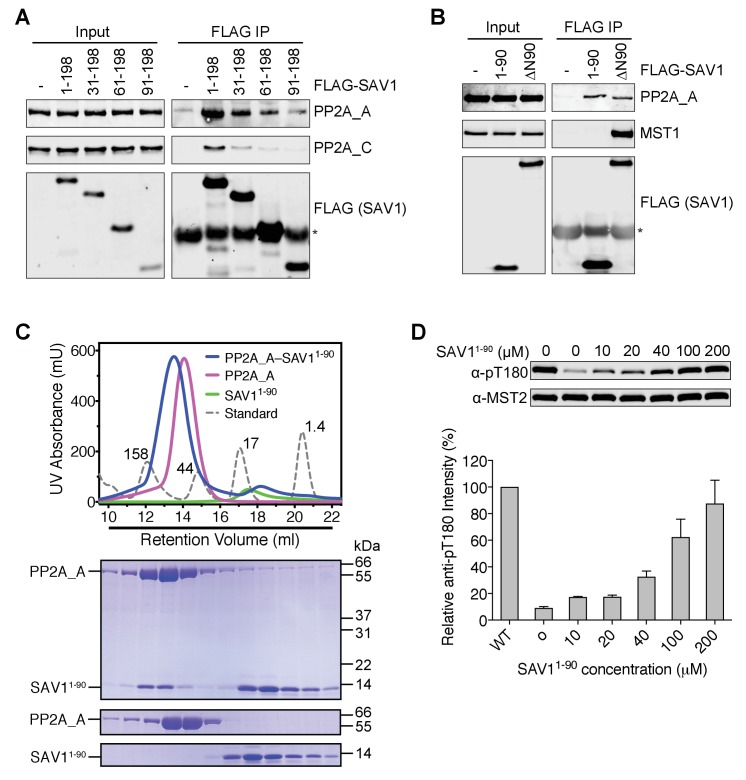
The N-terminal region of SAV1 directly inhibits PP2A.(A and B) Association of PP2A A-C with the N terminal region of SAV1. 293FT cells were mock transfected or transfected with the indicated FLAG-SAV1 plasmids. The total cell lysates (input) and anti-FLAG IP were blotted with the indicated antibodies. Asterisk designates IgG. (C) UV traces of the PP2A A and SAV11-90 complex (blue line), PP2A A alone (magenta line), SAV11-90 alone (green line), and molecular weight standard (dashed line, corresponding molecular weight indicated in kDa) fractionated on a Superdex 200 gel filtration column, respectively. The underlined fractions were separated on SDS-PAGE and stained with Coomassie. (D) The N-terminal region of SAV1 directly inhibits dephosphorylation of MST2 pT180 by PP2A. Quantitative MST2 pT180 and total MST2 immunoblotting of phosphatase reactions containing human MST2 and SAV11-90 at the indicated concentrations. The relative anti-pT180 intensities were normalized against MST2 without PP2A phosphatase treatment (100%). Data are representative of at least two independent experiments.